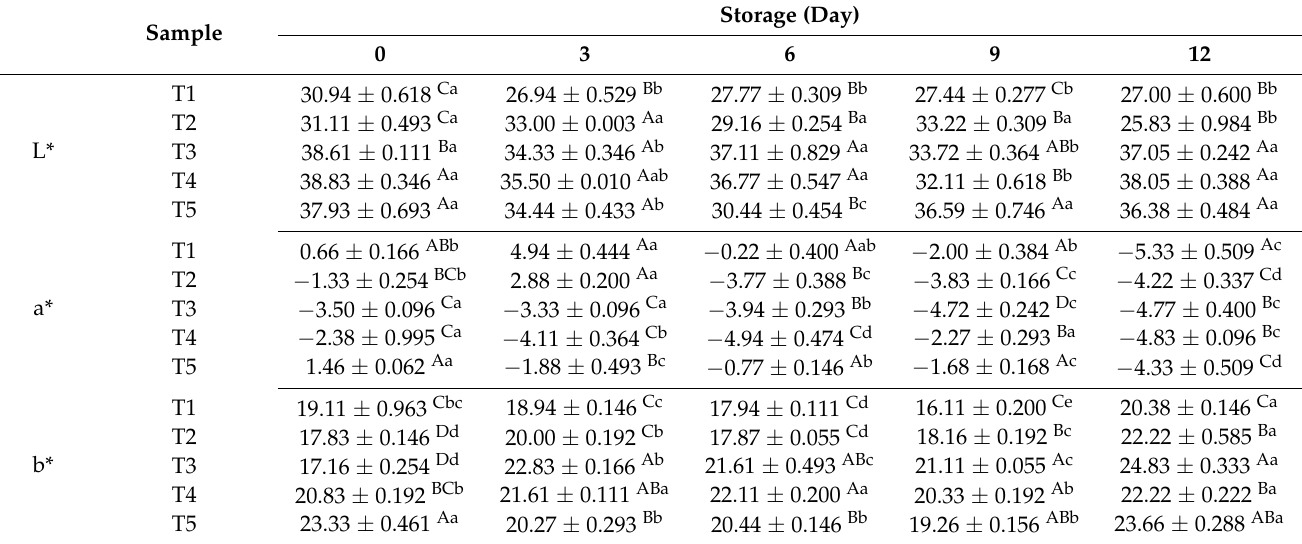
Table 4. Color indexes of chicken meat coated with chitosan containing AFEOs during storage at the 4 ◦